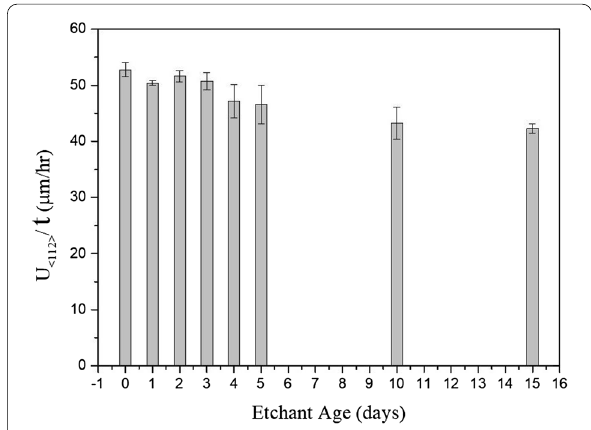
10M NaOH) on the +